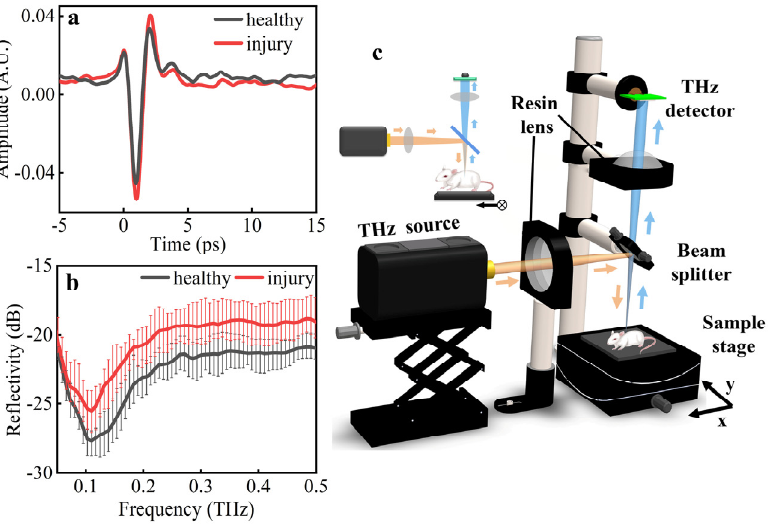
Figure 2. Experimental measurement of THz ( a ) time-domain waveforms and ( b ) reflective spectra of ALI samples. ( c ) Optical design of reflective THz imaging system for ALI.